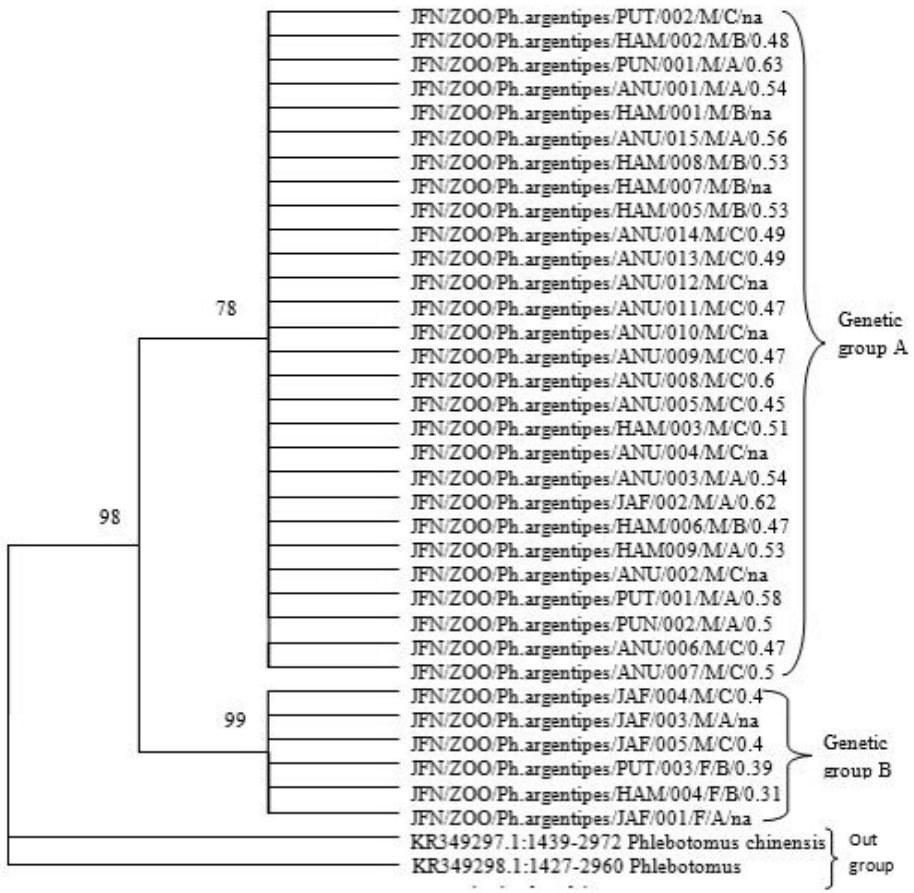
Figure 1: Molecular phylogenetic analysis by maximum likelihood method; Tamura-Nei model was selected based on the lowest BIC (Bayesian Information Criterion) scores. Non-parametric bootstrapping was performed (100 replicates) to validate the tree.